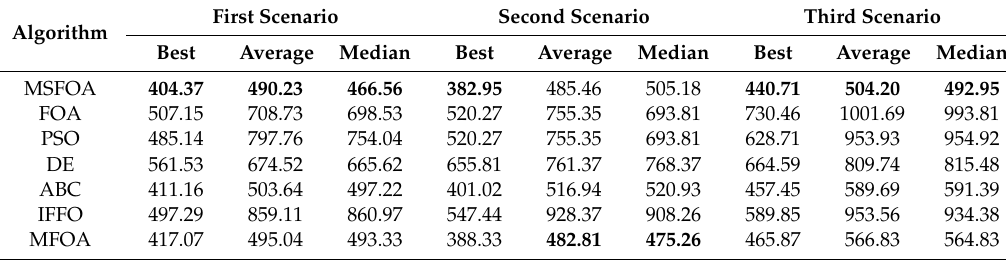
Figure 7. Convergence curves of the average best values for the third scenario. Table 3. The statistical results of cost of the path in different scenarios.